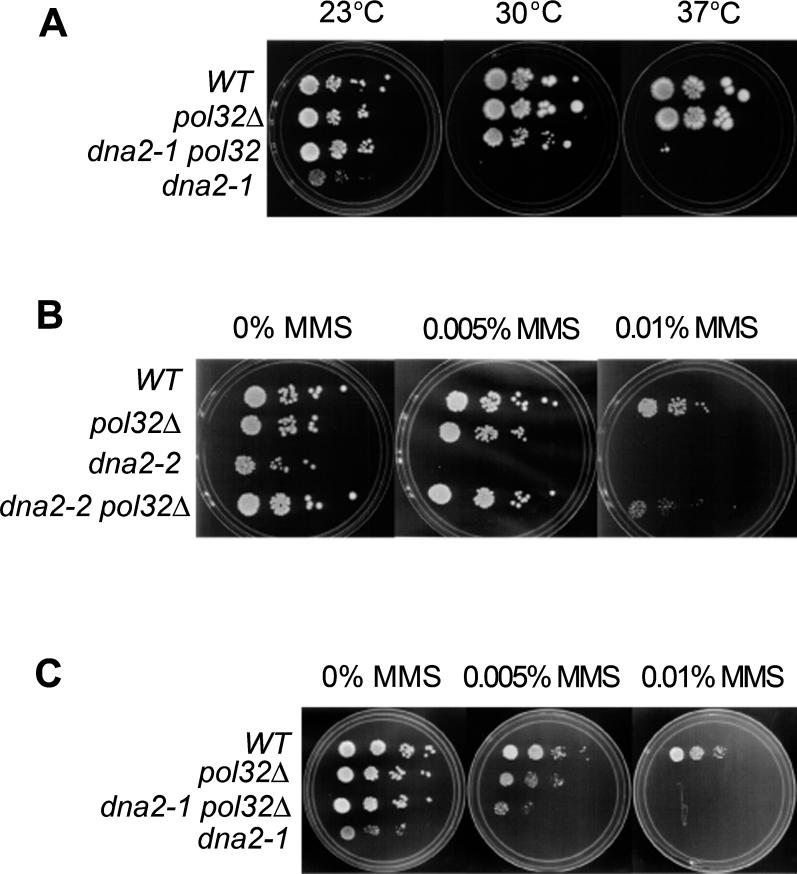
Suppression of Slow Growth and MMS Sensitivity of dna2 Mutants by pol32Δ(A) WT, pol32Δ, dna2–1 pol32Δ, and dna2–1 strains were grown to log phase, serially diluted, and plated on YPD plates and incubated at 23 °C, 30 °C, and 37 °C for 5 d.(B) WT, pol32Δ, dna2–2, and pol32Δ dna2–2 strains were grown to log phase, serially diluted, and incubated on MMS-containing YPD plates for 3 d at 30 °C.(C) WT, pol32Δ, dna2–1 pol32Δ, and dna2–1 strains were grown to log phase, serially diluted, and grown on MMS-containing YPD plates for 5 d at 23 °C.All strains are isogenic with strain 4741 (Table S4). (dna2–1 grows slowly even at 23 °C, and plates at 23 °C were photographed before they were fully grown so that the other strains would not be overgrown.)